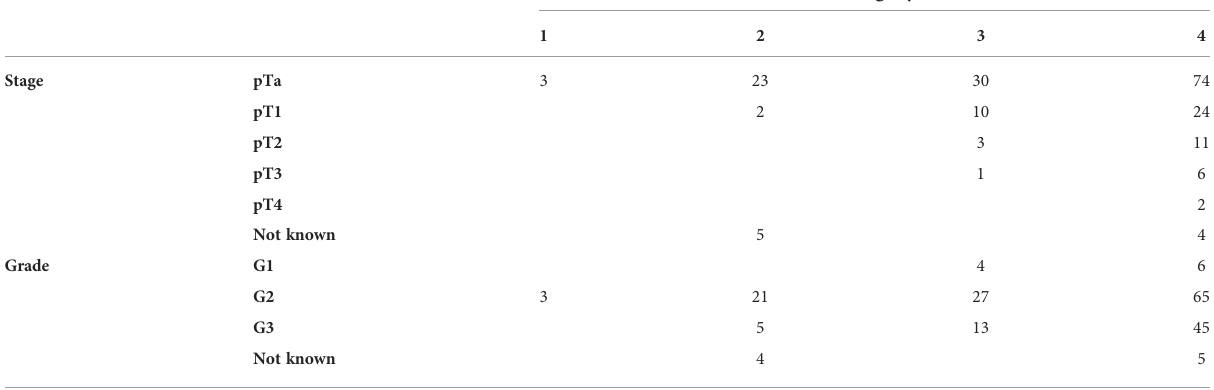
TABLE 4 Bladder cancer stage and grade for each